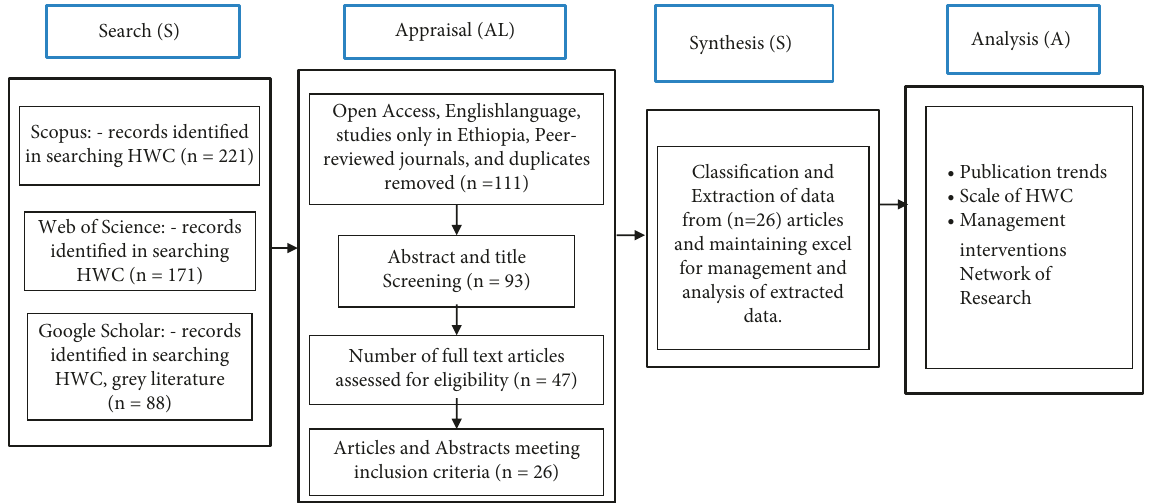
Figure 1: Flow diagram using SALSA